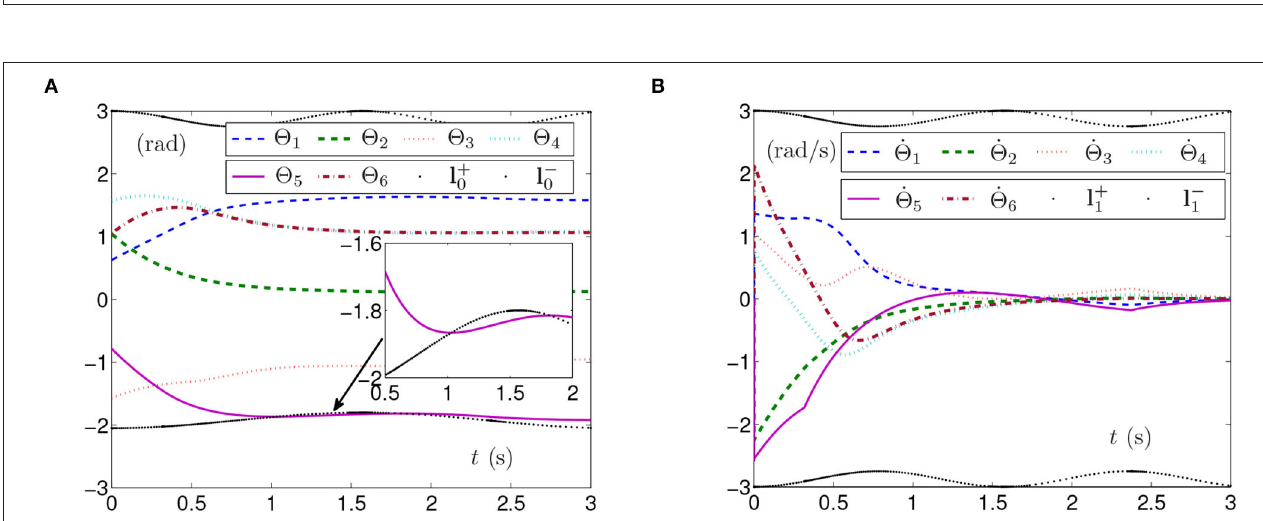
FIGURE 4 | Synthesized results of the planar manipulator using SMCS-1 with time-varying physical limits unsatisfied in case B. (A) Profiles of joint angles. (B) Profiles of joint-angle velocities.